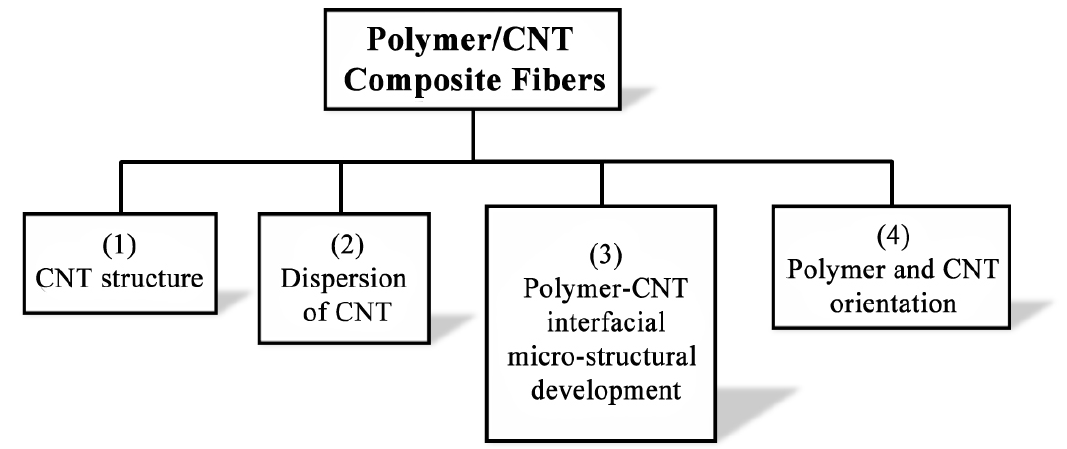
Figure 3. Four major factors affecting the micro-structural development in polymer/CNT composite fiber during